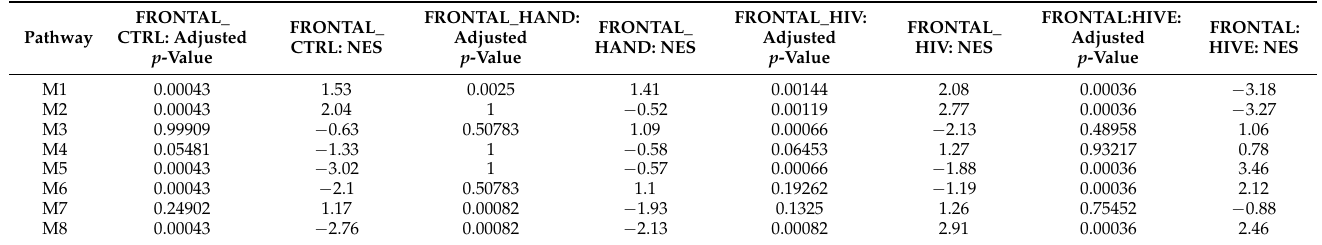
Figure 1. Gene co-expression network modular analysis. Modules enriched by the co-expression network modular analysis of the GSE35864 dataset. The heatmap is color- and size-coded based on the NES (normalized enrichment score) and statistical significance. Table 2. Results for the gene co-expression network modular analysis performed on the GSE35864